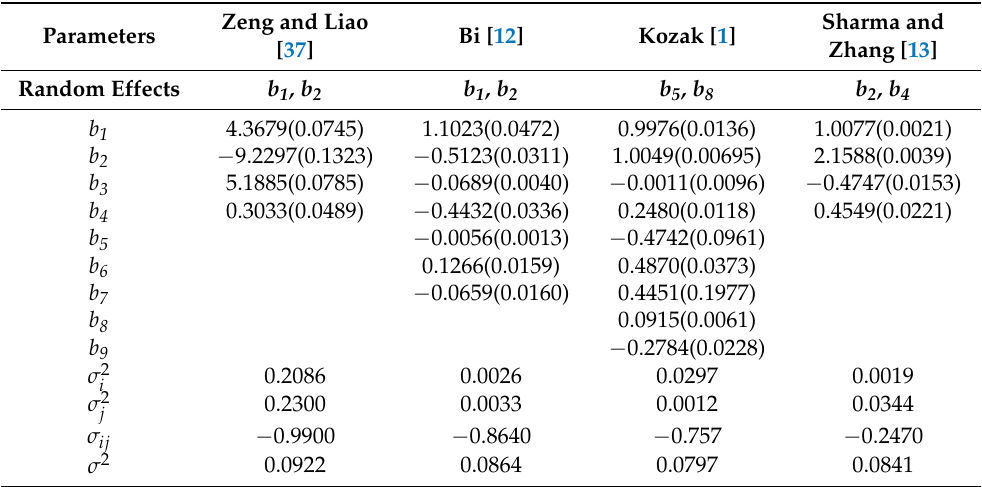
Table 5 respectively shows fixed parameter and random parameter estimated values of four variable-exponent taper equations based on tree-level effect mixed model. It can be found that all parameters are statistically significant. Table 6 shows the fit statistics comparison of four variable-exponent taper equations in the traditional least square method and those based on plot-level effect, tree-level effect, and nested two-level effect. The simulation precision in mixed mode based on plot, tree-level effect, or nested two-level effect is higher than that of the traditional least square method. The simulation precision based on tree-level effect and nested two-level effect is higher than that based on plot-level effect mixed model. The determination coefficient of mixed effect model based on plot-level effect is higher than that of the basic model by 0.0016–0.0020. The determination coefficient of mixed model based on tree-level effect and nested two-level is higher than that of the mixed model based on plot-level effect by 0.0104–0.0117. The simulation precision of the mixed model based on the tree-level effect and nested two-level had no prominent difference. Bi [12] model has the highest precision in the least square method basic model and the mixed model of nested two-level. Kozak [1] model has the highest determination coefficient and the lowest root-mean-square error in the mixed model based on tree-level effect and nested two-level effect. It is consistent with the goodness of fit indicators AIC, BIC, and -2LL. Table 5. Parameter estimates and variance components of the tree levels nonlinear mixed-effects (NLME) (standard errors in parentheses).